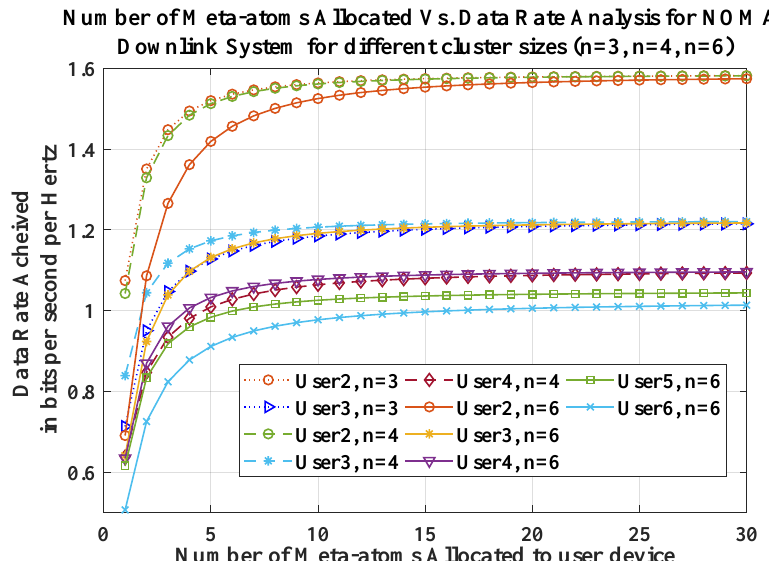
Figure 5. Data-rate plot analysis for lower channel gain user devices in downlink NOMA